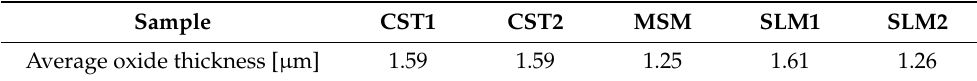
Table 3. The average thickness of oxide layers covered the examined alloys.